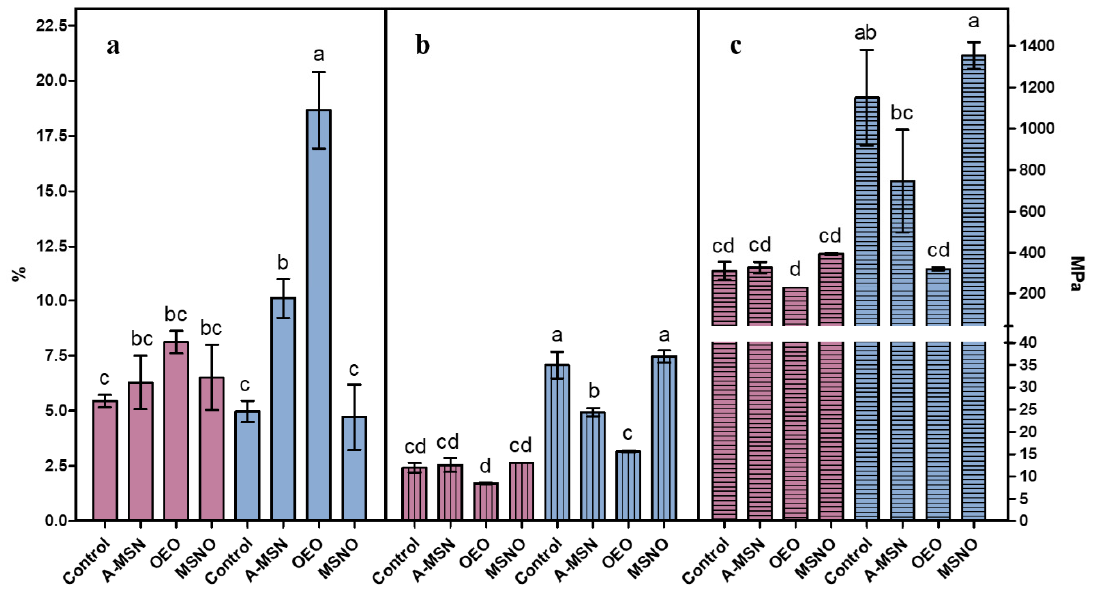
Figure 5. Mechanical properties of active edible films with 9:1 (amaranth protein isolate:chitosan, w / w ratio) (red) and 4:1 (amaranth protein isolate:chitosan, w / w ratio) (blue), added with amino- functionalized mesoporous silica nanoparticles (A-MSN), emulsified oregano essential oil (OEO), or mesoporous silica nanoparticles loaded with oregano essential oil (MSNO). ( a ) Elongation (%); ( b ) tensile strength (MPa); ( c ) Young’s modulus (MPa). Columns not connected with the same letter are significantly different ( p < 0.05).